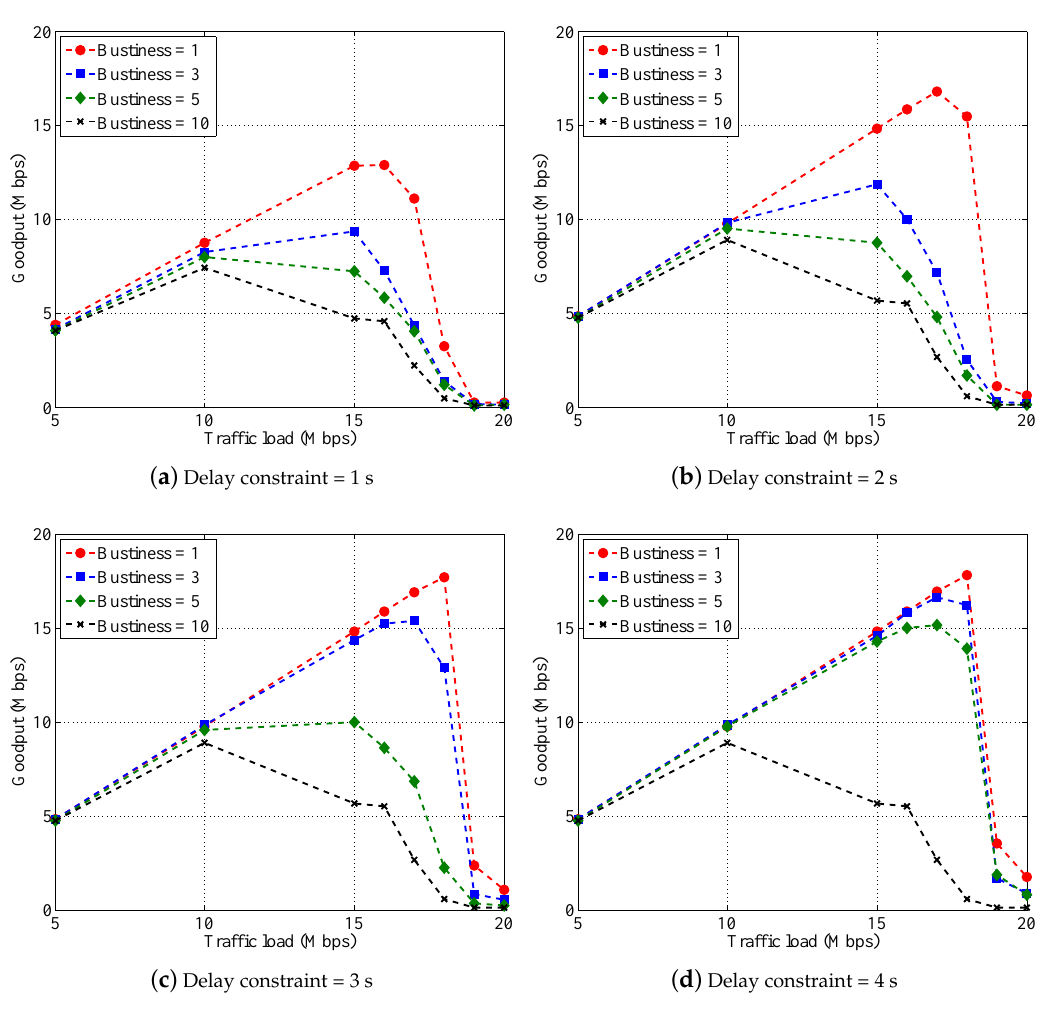
Figure 11. The goodput when the spectral efficiency is 3 bps/Hz when the traffic load varies from 5–20 Mbps and burstiness varies from 1–10